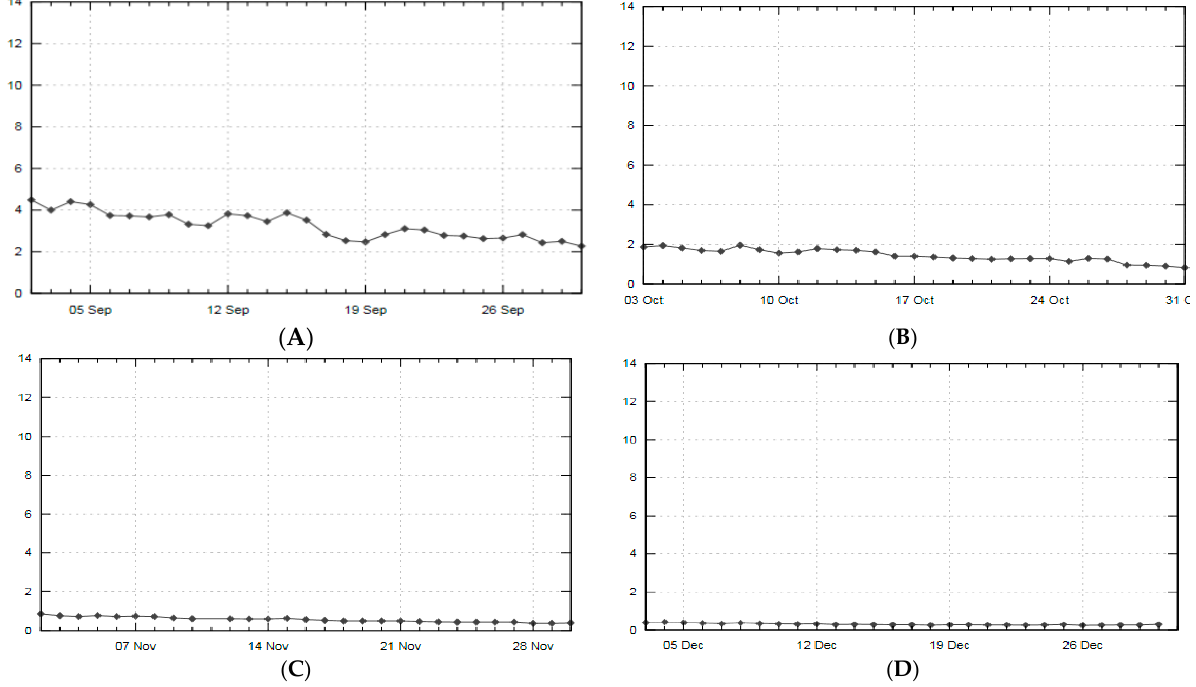
Figure 1. Scope of the UV index for the city of Gdynia (Poland) in the research period (( A )-September, ( B )-October. ( C )-November, ( D )-December) [27].